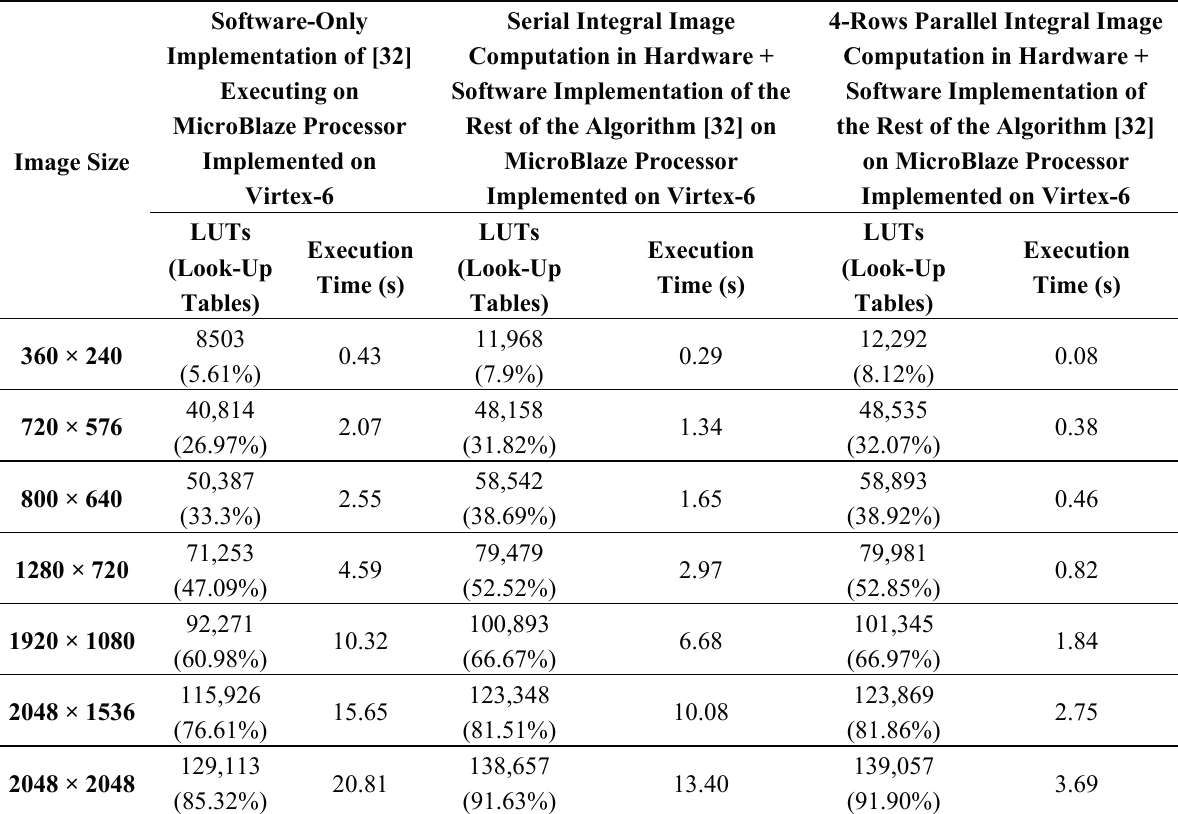
Table 4. Comparative FPGA resource utilization and timing results for the three prototype implementations of the fast adaptive binarization algorithm [32] on a Xilinx Virtex-6 XC6VLX240T FPGA for some common image sizes with 8-bit pixels. The values in parenthesis indicate the percentage of Virtex-6 resources